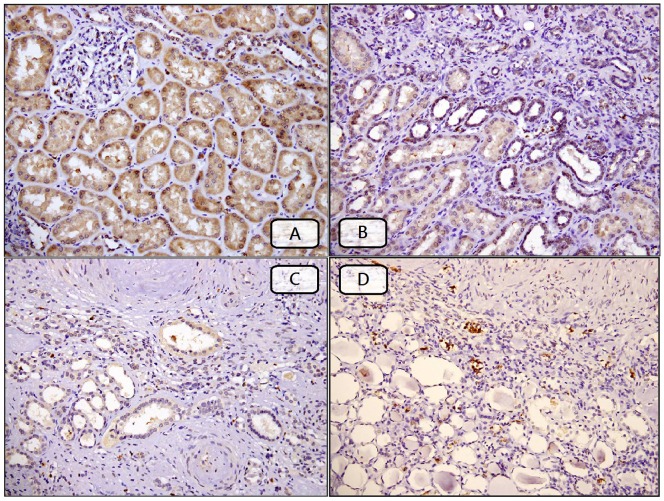
Representative panels showing different expression intensity of MMP-9 in atrophic tubular nuclear compared to normal tubular cytoplasm nearby fibrotic renal parenchyma.(A) no fibrosis with increased cytoplasm stain in normal tubules, (B) mild fibrosis with decreased cytoplasm stain in normal tubules and increased nuclear stain in atrophy tubules, (C) severe fibrosis with decreased cytoplasm stain in normal tubules, and (D) severe fibrosis with increased nuclear stain in atrophy tubules. (IHC stain, x 20).